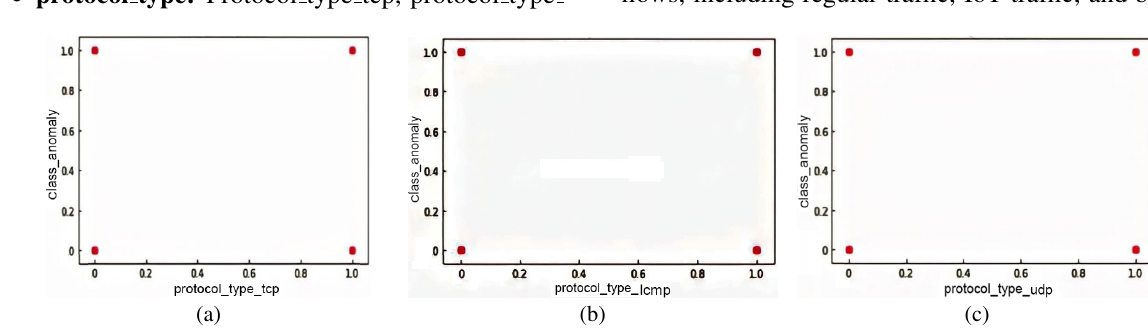
Fig. 3 Graphic visualization for different variables of protocol